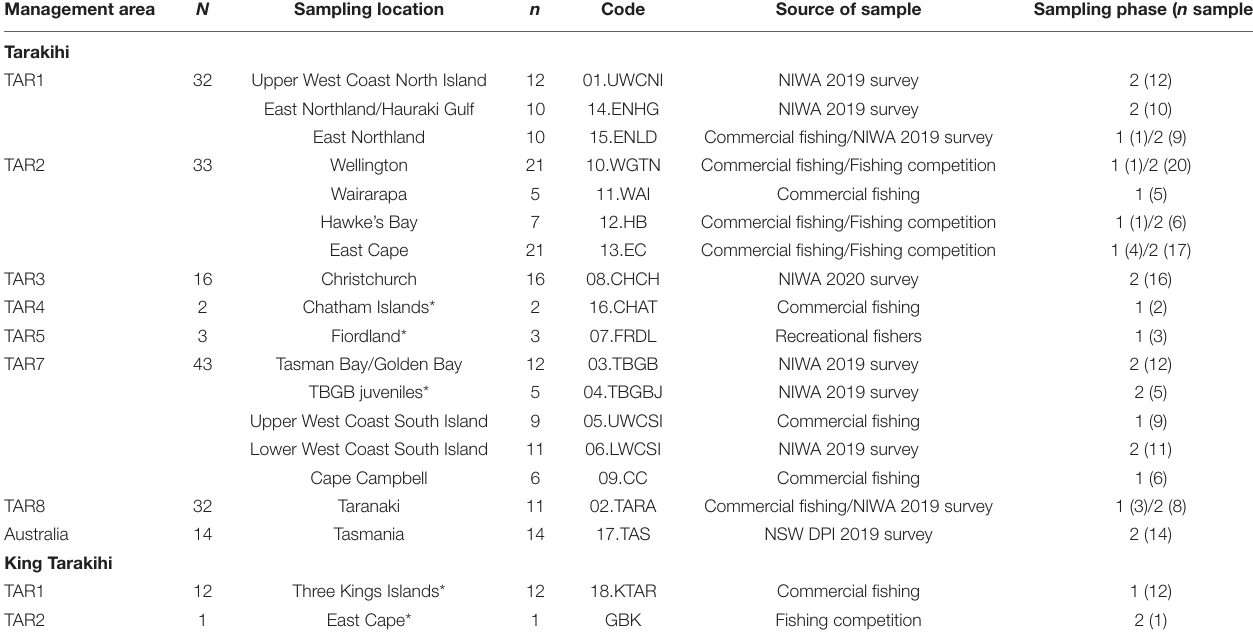
TABLE 1 | Sampling sites and sample